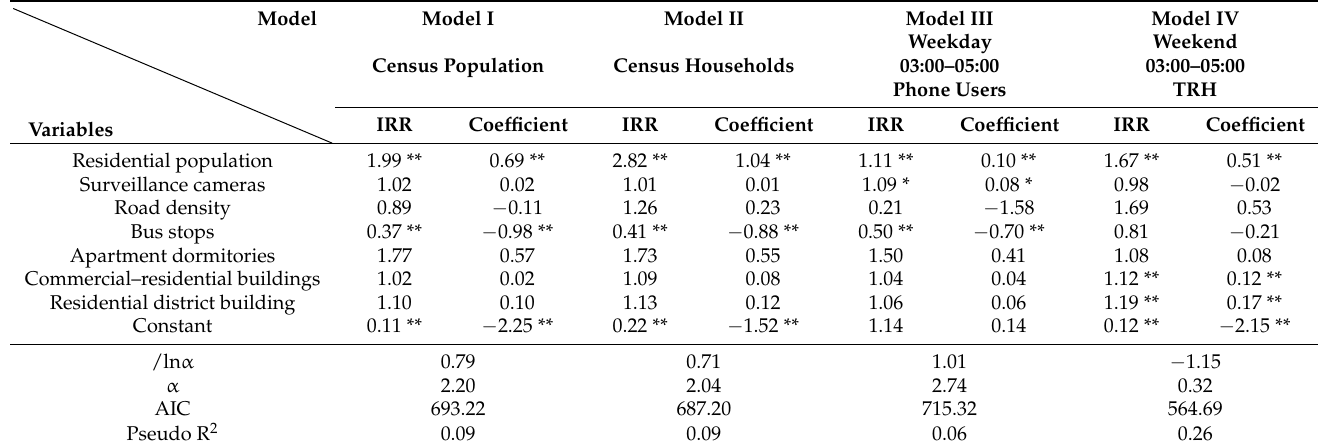
Figure 5. AIC values of various residential population indicators in the negative binomial regres- sion model. Table 4. Results of the negative binomial regression